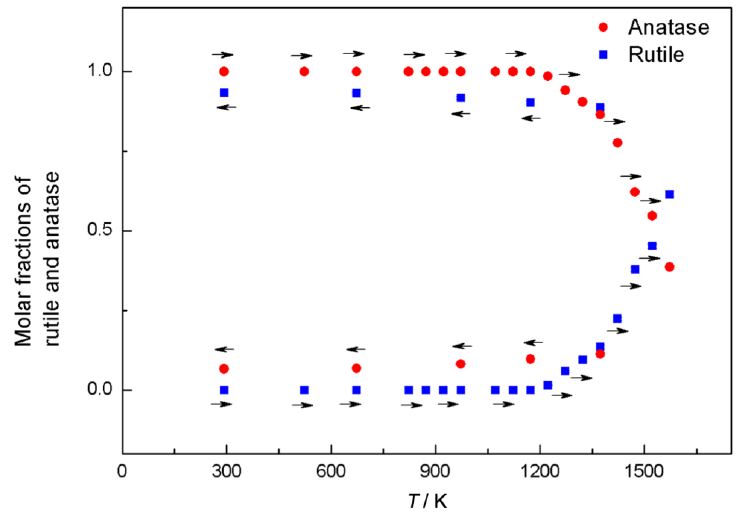
Figure 3. The dependence of molar fractions of anatase, A , and rutile, R , on temperature of the as-synthesized TiO 2 during the heating and cooling cycles. The arrows indicate the sense of the temperature change [19].